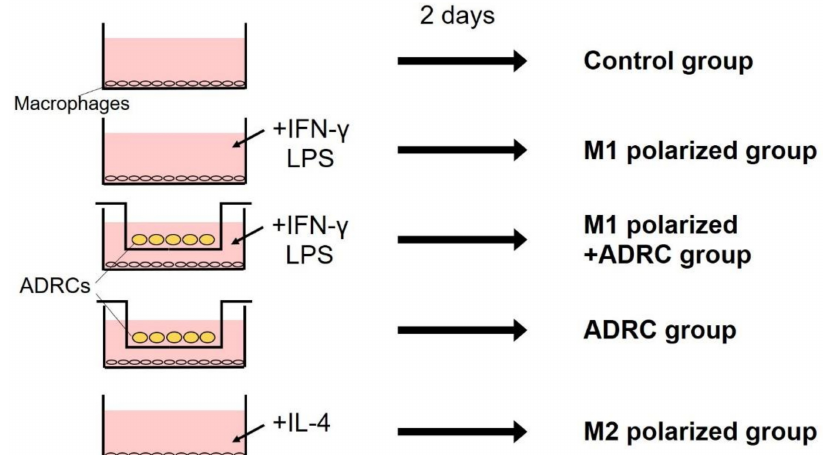
Figure 1. Summary of in vitro experiment. Macrophages were then divided into five groups and